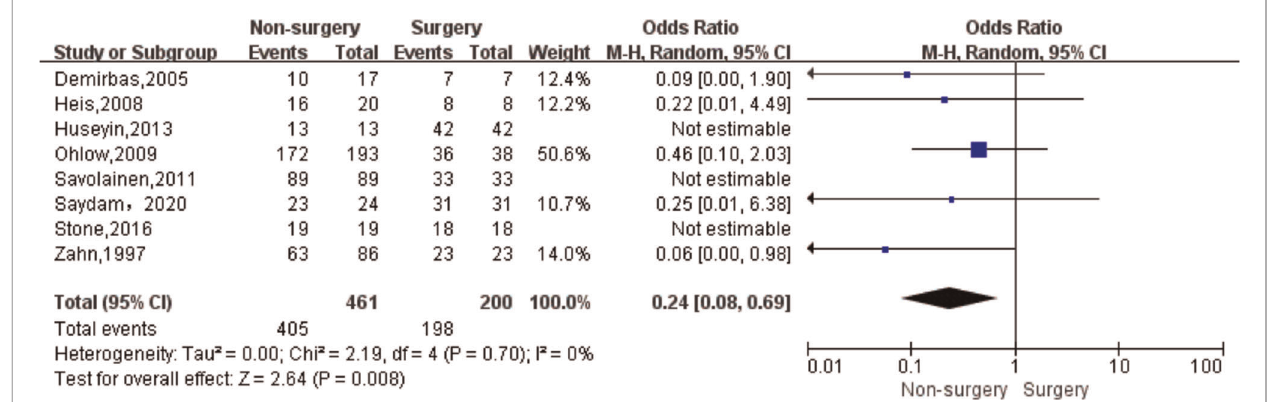
FIGURE 2 | Forest plot showing the pooled odds ratio for pseudoaneurysm treatment success rate after surgery and non-surgical